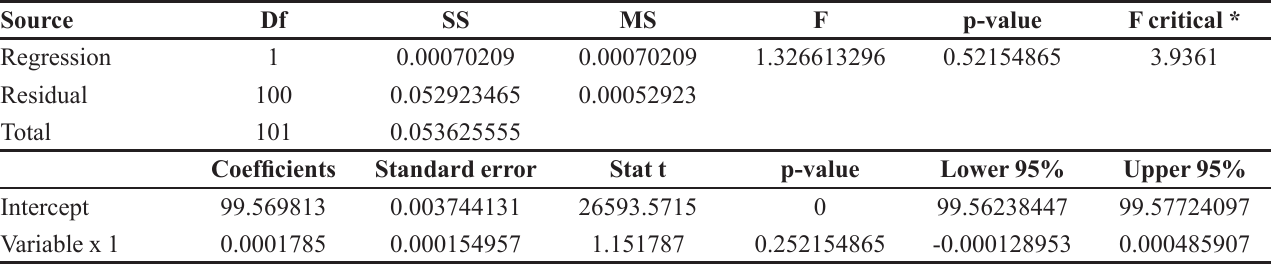
TABLE VI - Regression analysis for long-term stability results Source